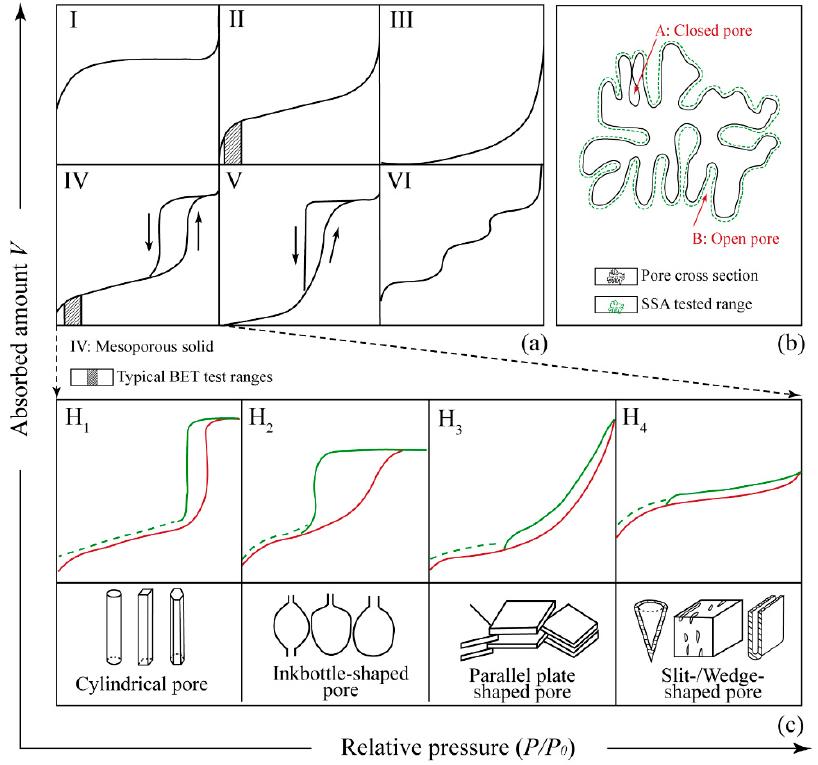
Figure 4. Type of adsorption isotherms and its corresponding pore types: ( a ) Type of adsorption isotherms; ( b ) specific surface area (SSA) tested range by Brunauer-Emmett-Teller (BET) test; ( c ) hysteresis loops and its corresponding pore shapes.